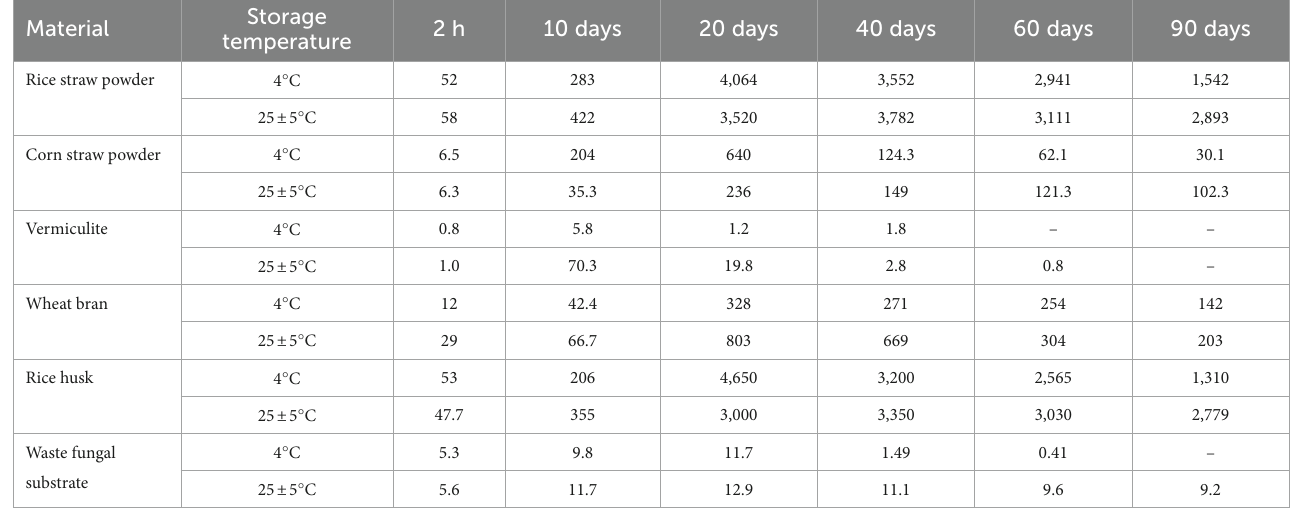
TABLE 2 Effective number of living bacterial cells (×10 6 cfu/g) grown with different immobilizing materials at different storage temperature and time.